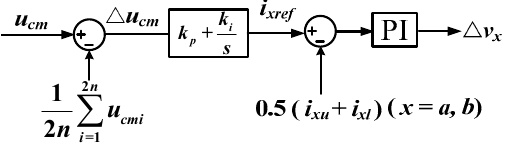
Figure 5. Average control of the proposed DC-DC MMC.